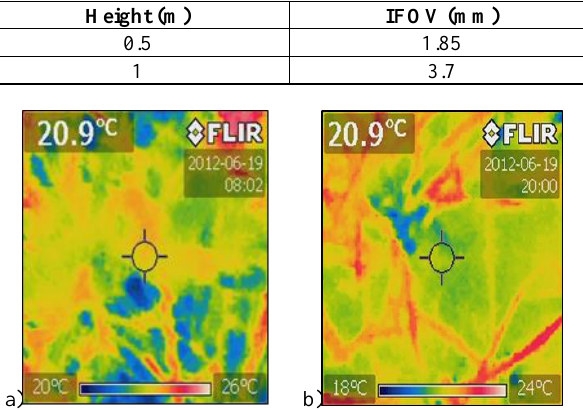
Figure 6: Nadir FLIR measurement of control sample; a) Daytime measurements, b) Nighttime measurement